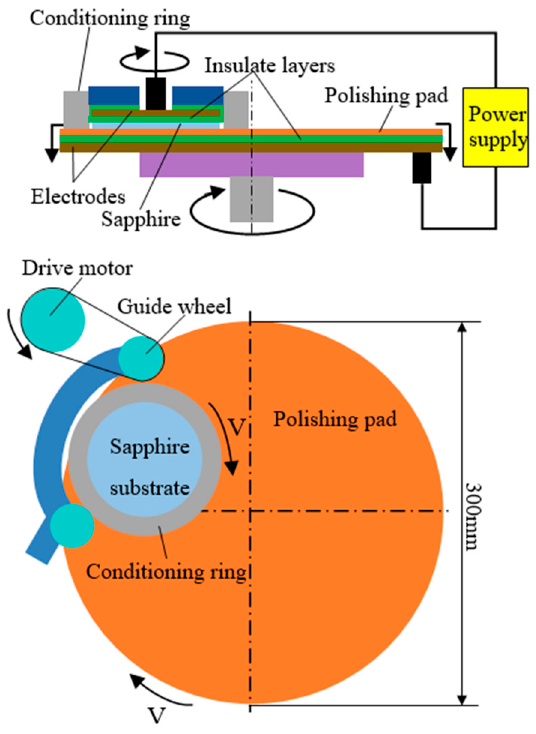
Figure 3. Schematic diagram of the DEPP apparatus.